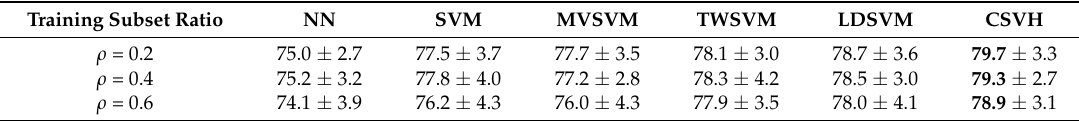
Table 4. Diagnosis accuracy on atrial hypertrophy data